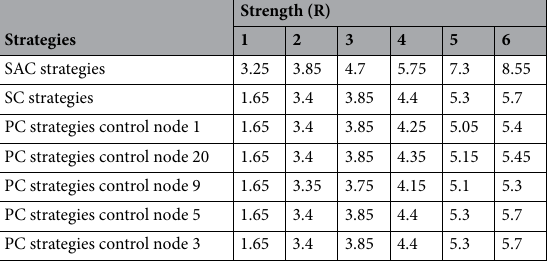
Table 5. Comparison of RTS-Average of network stability restoration under different control strategies.